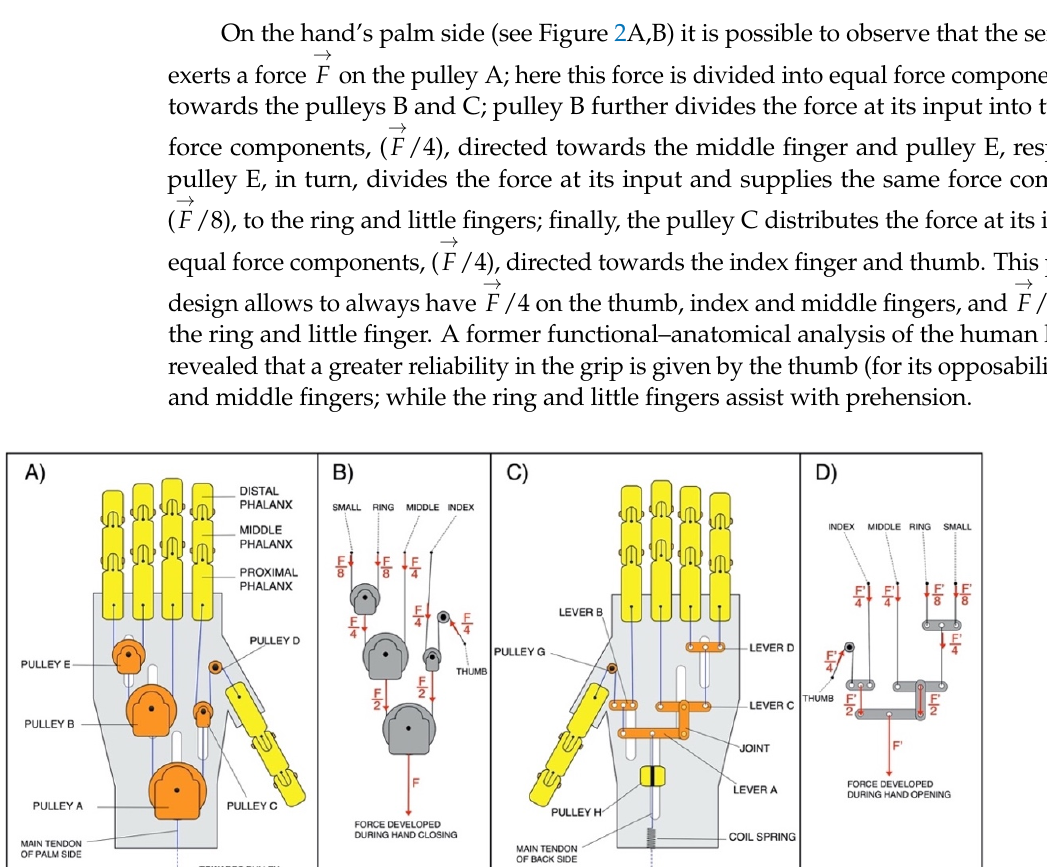
Figure 1. 3D renderings of the “Federica” prosthetic hand: ( A ) Top view; ( B ) Side view; ( C ) Bottom view.